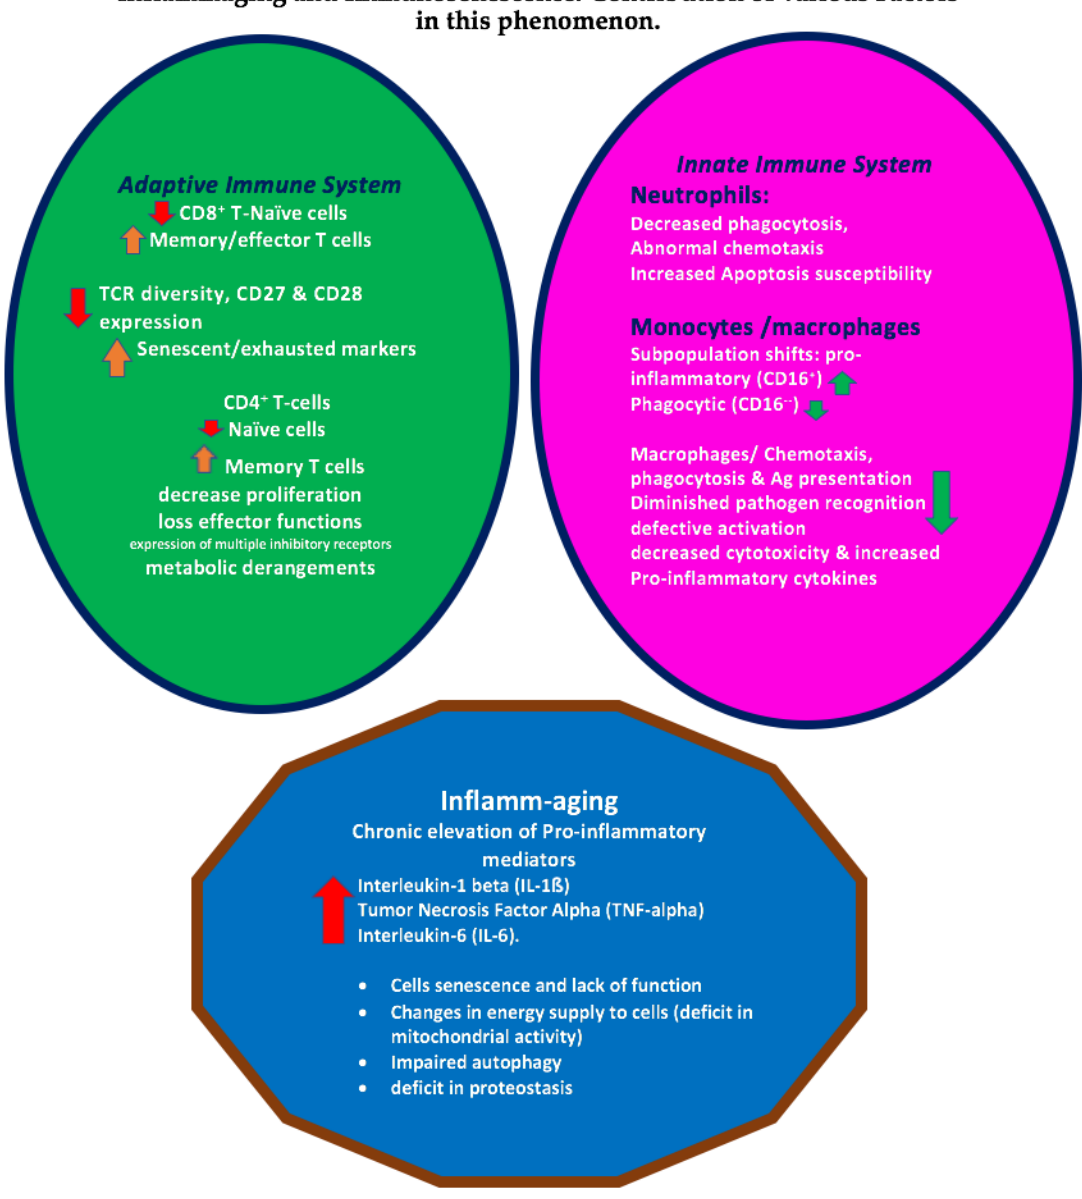
Figure 1. Immunological changes are observed during inflammaging and immunosenescence. Aging is a risk factor for many diseases. There are disturbances in a number of innate and adaptive aspects of immune cells that can impair or compromise their function and response to invaders and different pathogens. Additionally, aging causes alterations in intracellular homeostasis and increases the number of pro-inflammatory cytokines and chemokines, leading to